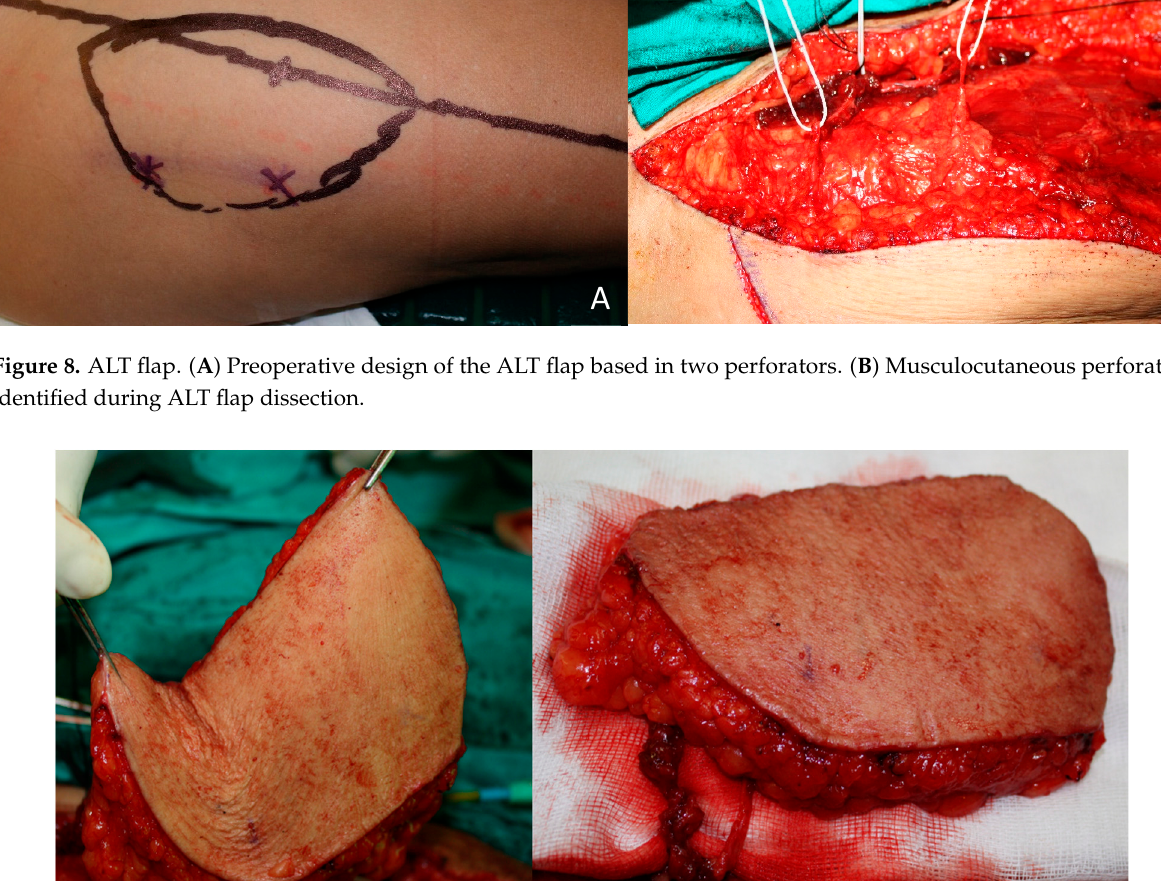
Figure 8. ALT flap. ( A ) Preoperative design of the ALT flap based in two perforators. ( B ) Musculocutaneous perforators identified during ALT flap dissection.